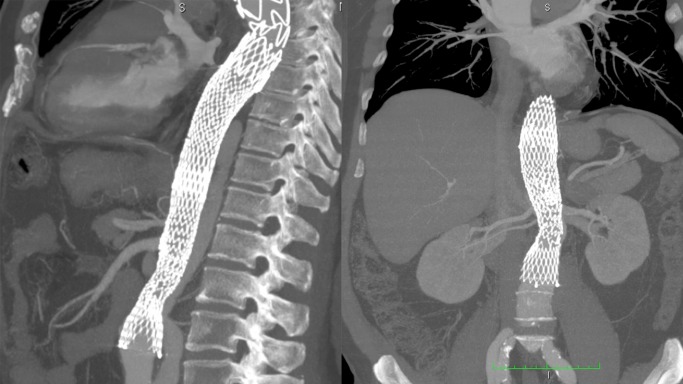
Placement of a stent at the level of the visceral arteries.